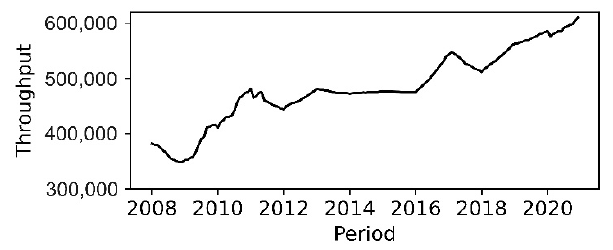
Figure 5. Time series plot of container throughput (CT) of Douala port (Source: author). The study variables were derived from berth and port cargo operations and